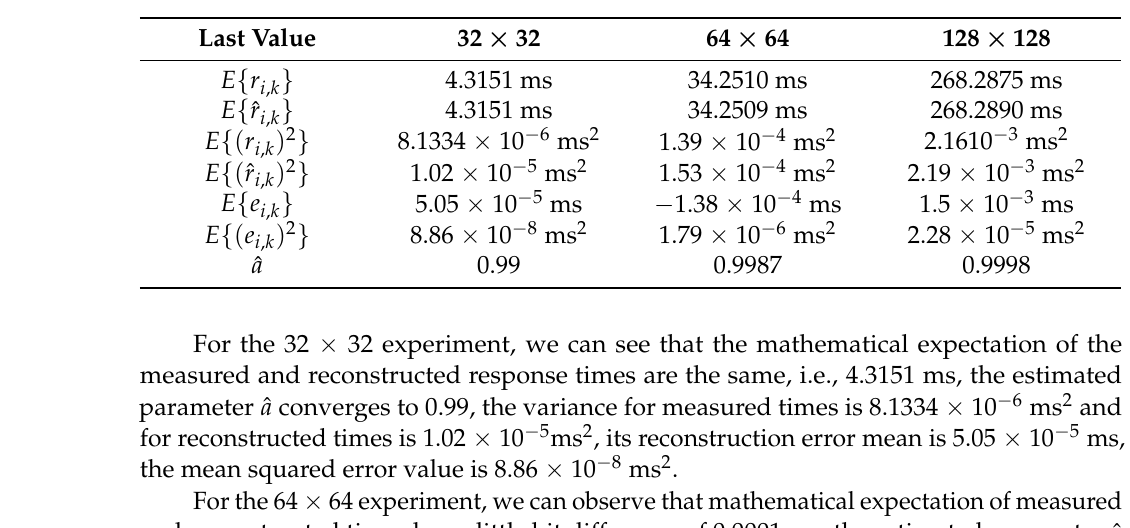
Figure 16. Graph of the reconstruction error and mean squared error for the 128 × 128 matrix inversion experiment. Table 3. Last values of the first and second probability moments for each